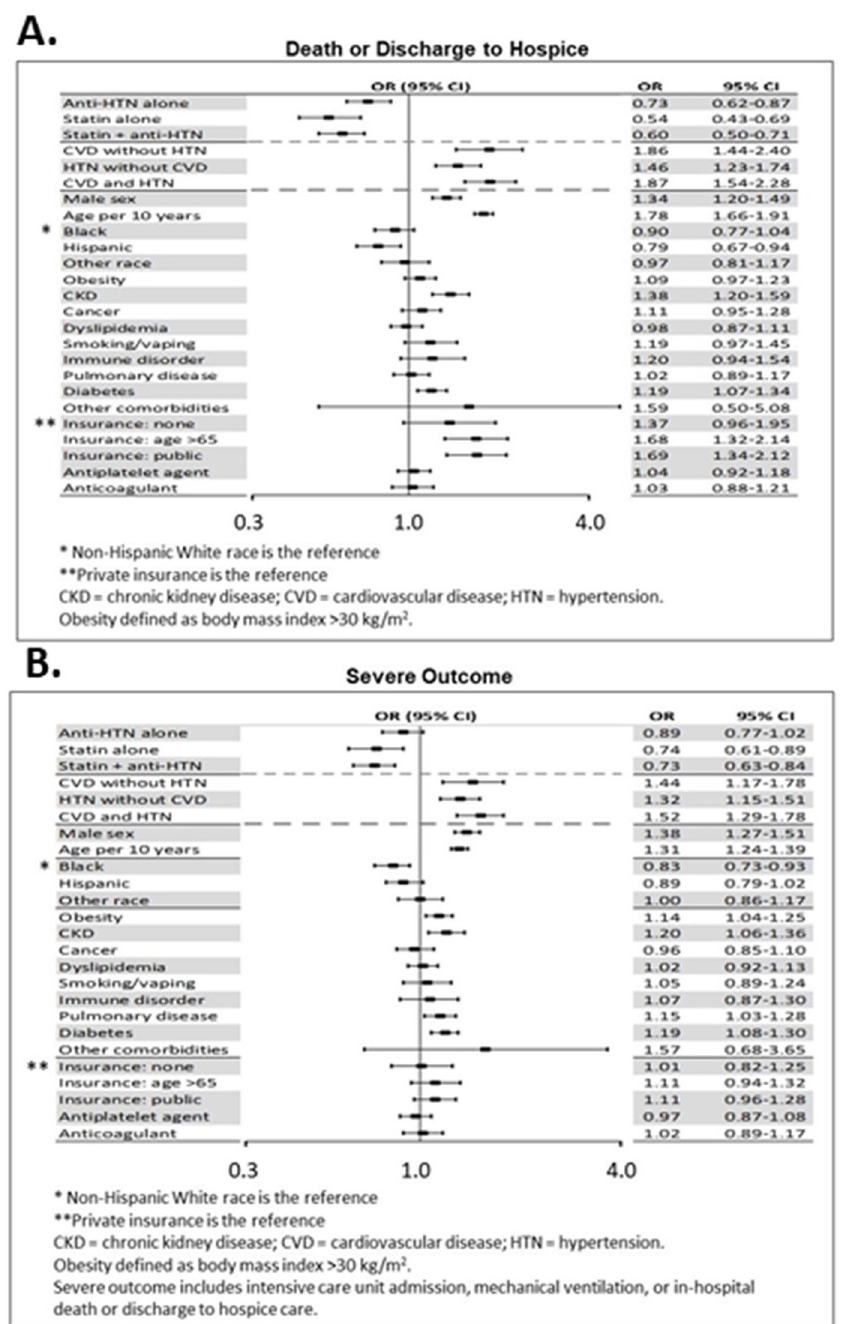
Fig 3. Multivariable predictors of outcomes. Predictors of (A) death or discharge to hospice, and (B) severe outcome, in a multivariable logistic regression model.